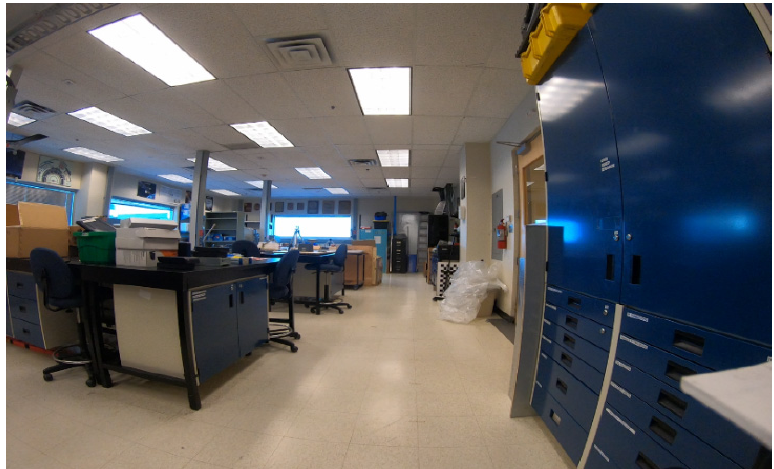
Figure 9. Lab area test